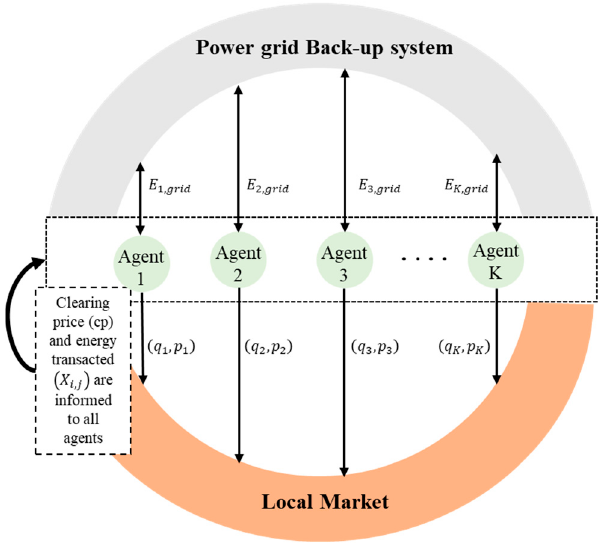
Figure 1. Local market and grid as a back ‐ up.